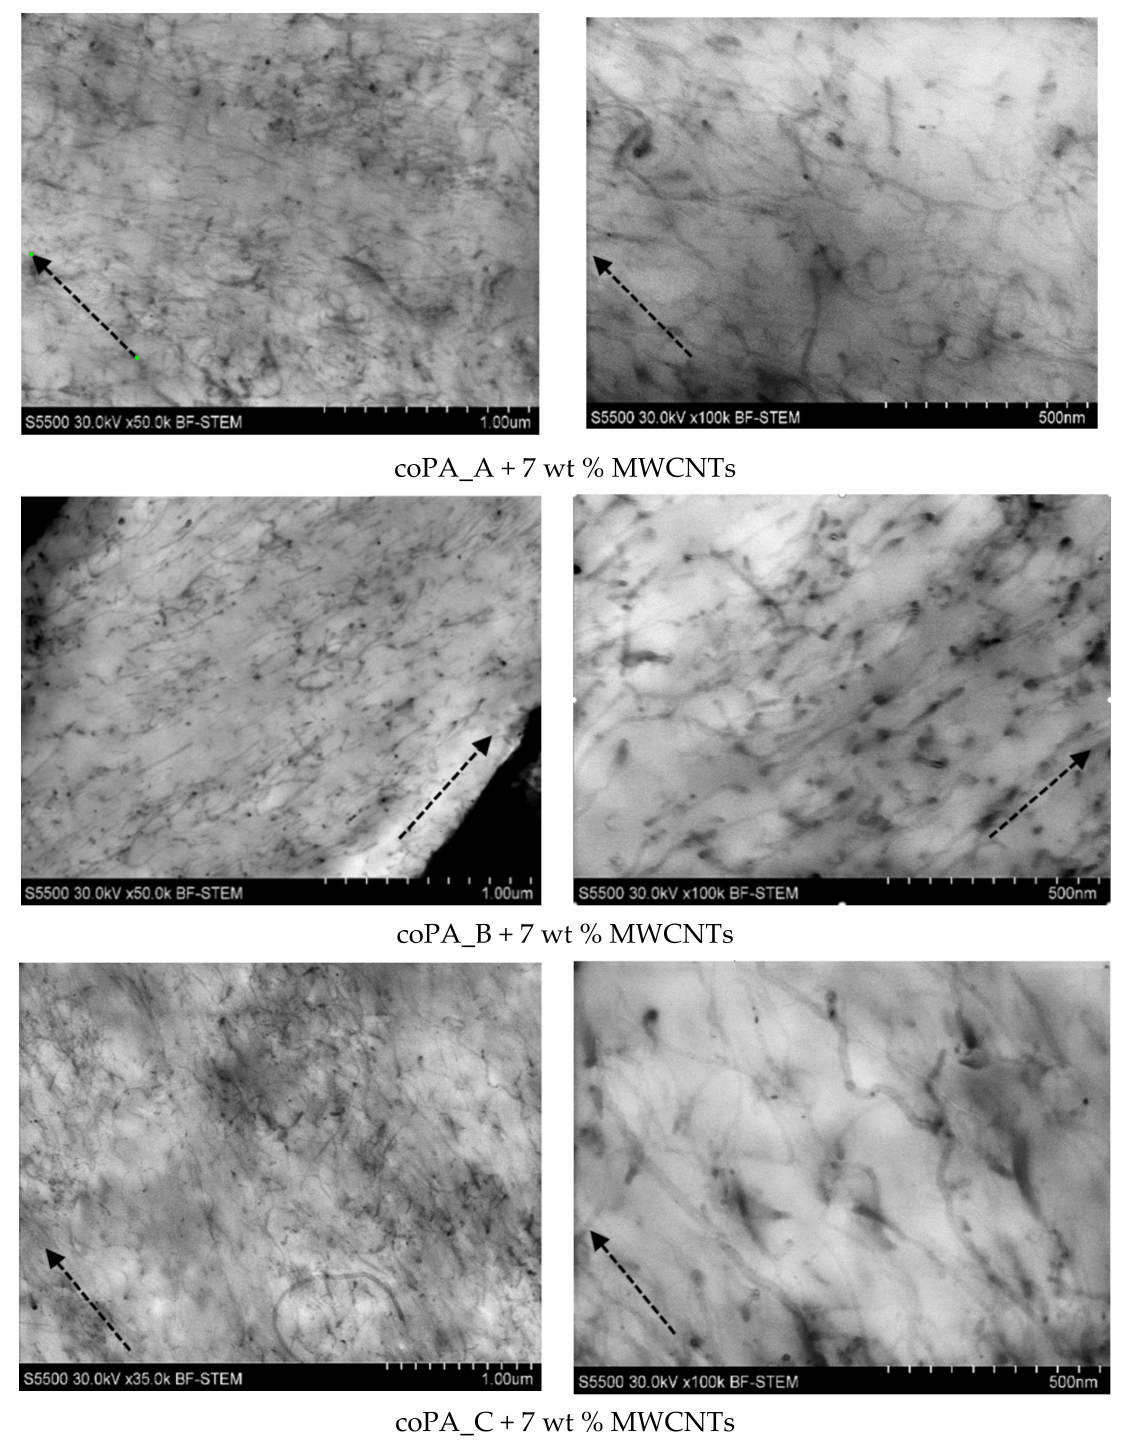
Figure 3. The state of MWCNTs’ dispersion and their arrangement in the nanocomposite fibers. The images were captured using a high-resolution microscope, along the axis of the